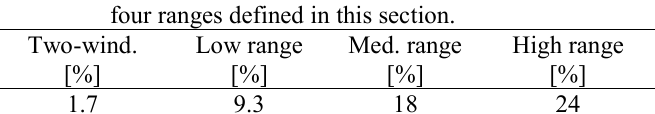
Table 1: The maximum relative errors of equation (11) with 𝑙 evaluated with the help of equation (12) for the four ranges defined in this